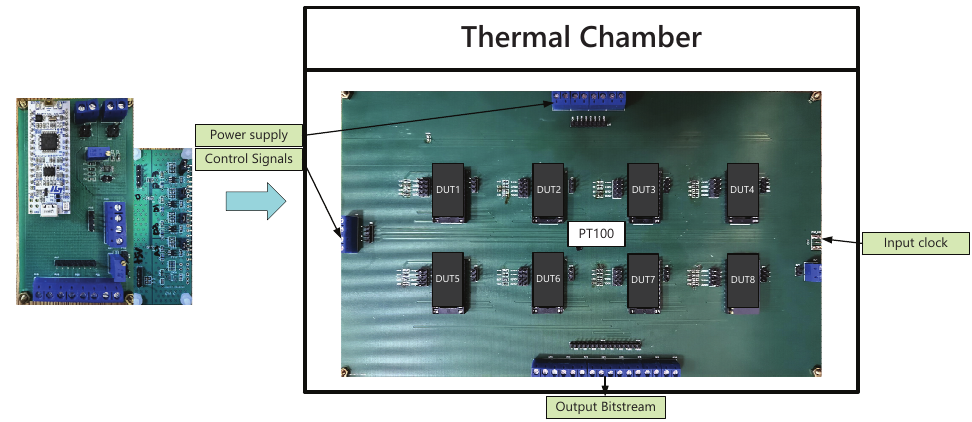
Figure 13. Test setup for the CMOS temperature sensors.